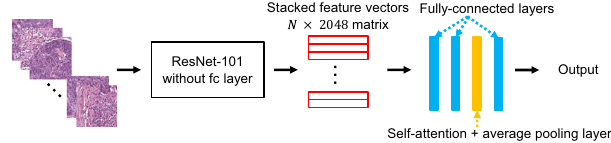
Fig. 1 The proposed network structure. Each color normalized tile is fed into a pretrained ResNet-101 to extract a 2048-dimensional feature vector. Feature vectors of all tiles of the same patient are stacked and fed into a MLP with self-attention to predict the mutation probability or pathway activity.